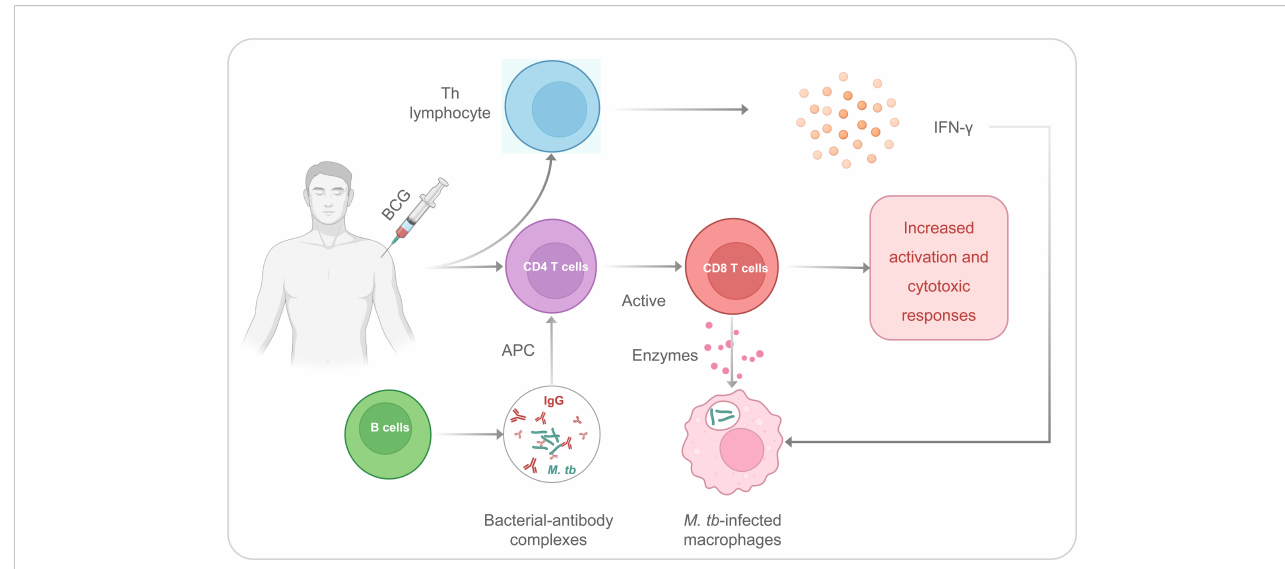
FIGURE 1 The Th and CD4/CD8 T cells are contributed to the adaptive immune responses induced by the